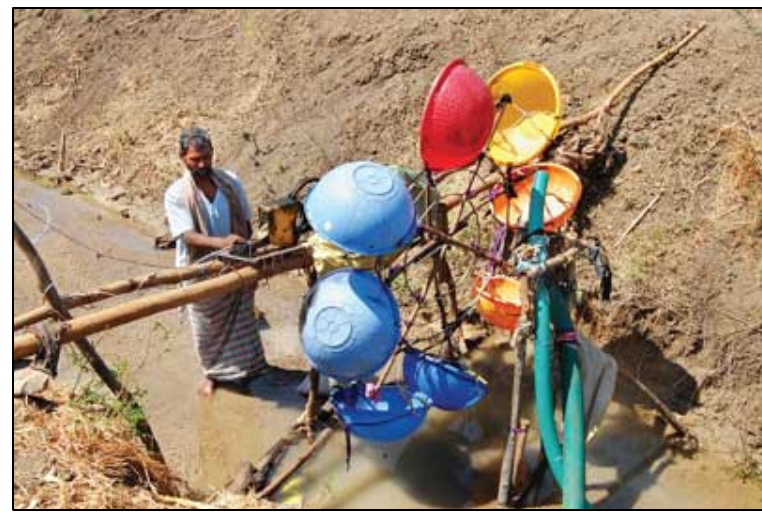
Figure 21. Karnataka farmers designed water mills to generate electricity for small farms (adapted from [53]).